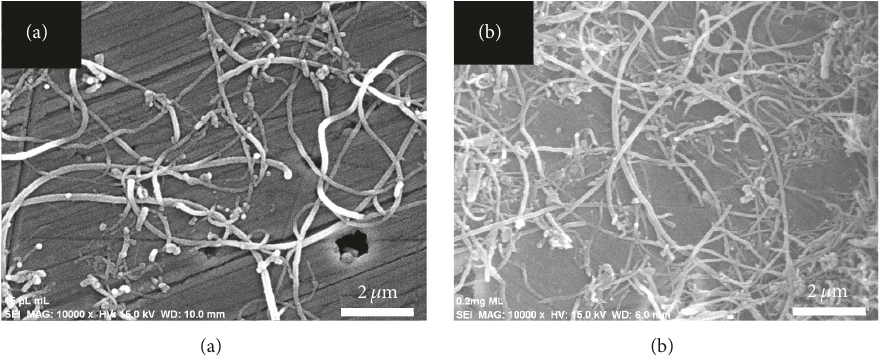
Figure 5: SEM images showing best concentration results from the dispersion of CNTs: (a) 0.30 mg/mL of EDTA and (b) 0.20 mg/mL of SDS.